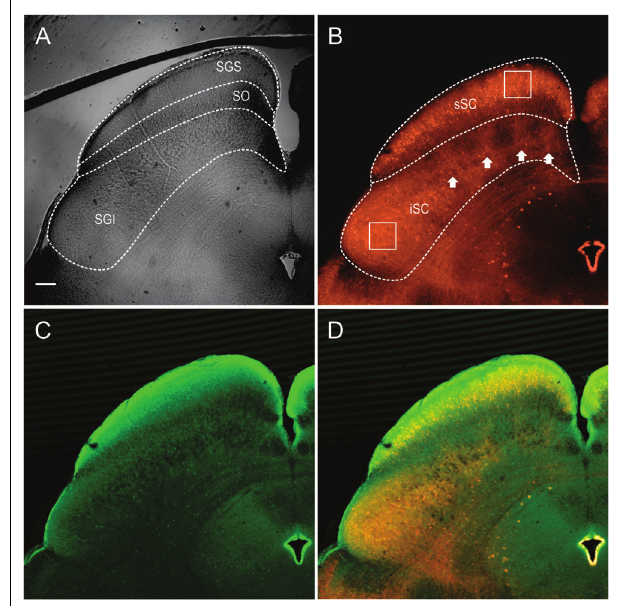
FIGURE 1 | Distribution of PV and GABA in the Ai9;PV-Cre mouse SC. (A) Differential interference contrast (DIC) image from an Ai9;PV-Cre mouse showing the left side of a 300 µ m slice through the SC and the layers (SGS; stratum griseum superficiale; SO, stratum opticum; sSC, superficial/visuosensory layers; iSC, intermediate/motor layer; SGI, stratum griseum intermediale). (B) Confocal image of the same section showing the distribution of PV + neurons and neuropil in both layers of the SC as visualized by tdTomato fluorescence. Squares on sections within the layers are shown in expanded view in Figure 2A . White arrows highlight the patchy distribution of PV + labeling in iSC. (C) Confocal image depicting the distribution of GABA + neurons and neuropil in the same section detected by GFP immunofluorescence using anti-GABA antibody. (D) Merged PV + and GABA + confocal images (B,C) . Scale bar: 200 µ